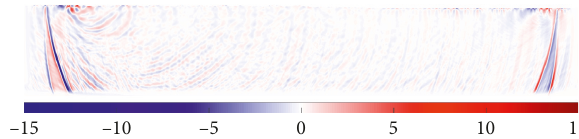
Figure 17: Velocity distribution in the x direction at time � 100s.